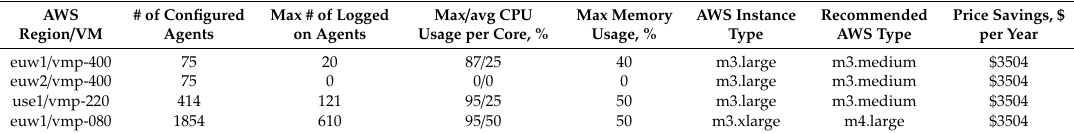
Table 5. Evaluation of AWS instances downscale and price savings.